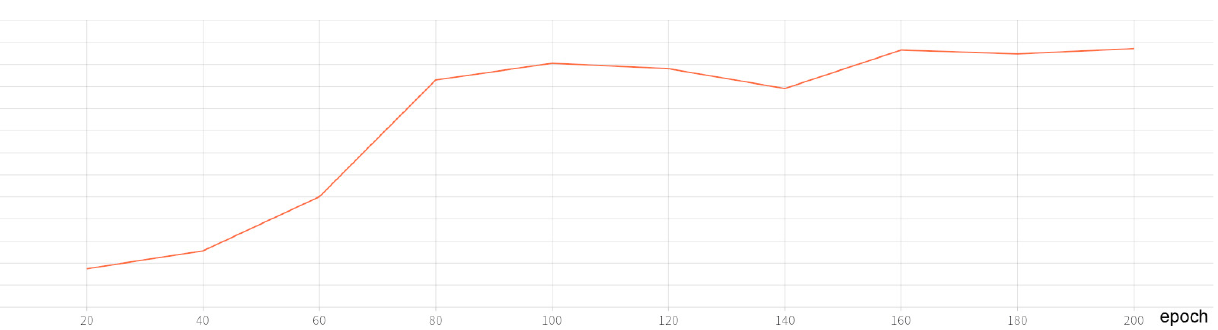
Figure 17. SSIM value variations curve during network training.